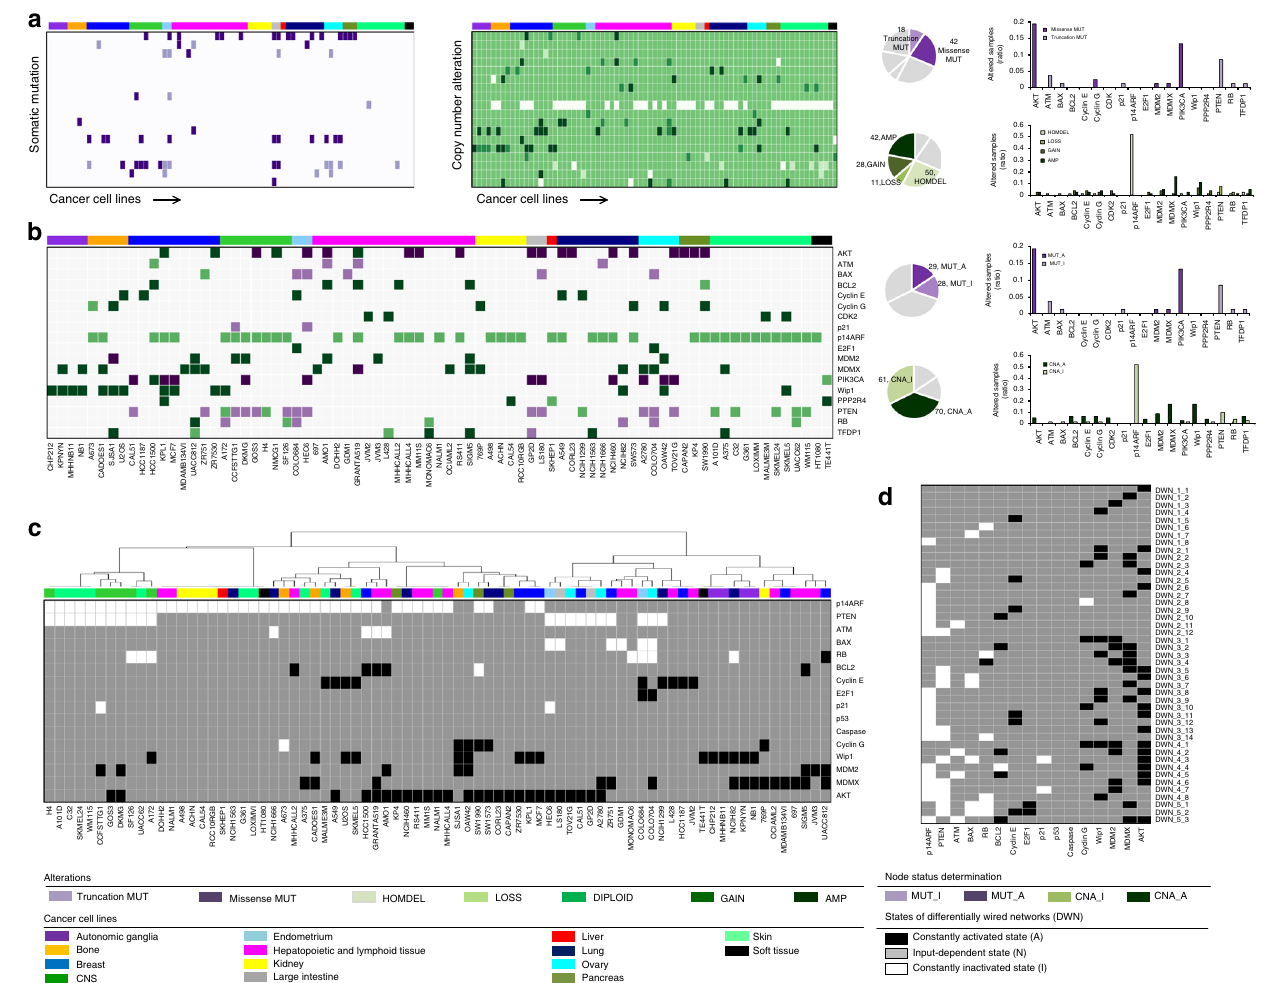
Fig. 2 Mapping cancer-associated genomic alterations to the p53 network. a Genomic alterations considered in our analysis include copy number alterations and somatic mutations. To select the functional genomic alterations, we fi rst reduced thousands of genomic alterations to a few hundred candidate functional events (heatmaps to the left). Copy number alterations (HOMDEL(homozygous deletion): white green; LOSS: light green; DIPLOID: bright green; GAIN: green; AMP(ampli fi cation): dark green, various shade of greens), and somatic mutations (truncation: light purple; missense: dark purple) de fi ne the genetic landscapes of the 83 human cancer cell lines from 14 cancer types (arranged from left to right with groups of columns labeled by cancer type). The selected alterations tend to involve well-known oncogenes and tumor suppressors (histograms) and the pie charts show the proportion selected. b Selected functional alterations that are either gain of function or loss of function. The selected alterations were associated with cancer cell lines in a binary fashion, such that a gene (protein) with the alteration was either constantly activated (A) or constantly inactivated (I), depending on its alteration type in a given cancer cell line (MUT_I: light purple; MUT_A: dark purple; CNA_I: light green; CNA_A: dark green). c Projection of the selected functional genomic alterations onto the nominal p53 network. Node status in the p53 network is determined in a ternary fashion, such that node activity is either constantly activated (A), constantly inactivated (I), or input-dependent (N) (A: black; N: gray; I: white). d The 45 distinct differentially wired p53 networks (DWNs) constructed based on the genomic data. Cancer cell lines that have the same node activity pro fi le were matched to an identical